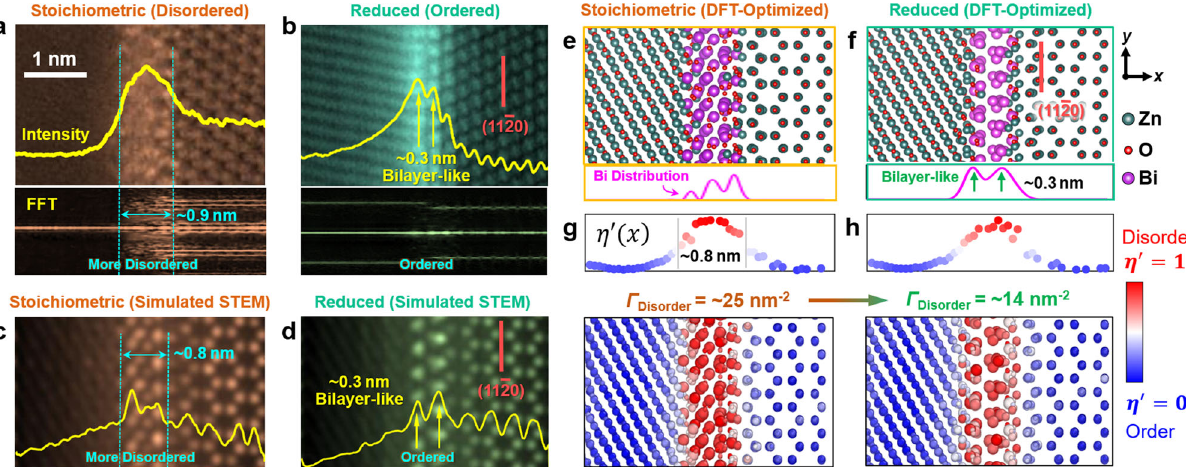
Fig. 5 Comparison of experiments and DFT simulations of stoichiometric (disordered) vs. reduced (ordered) GB structures and AIMD-simulated GB diffusivities. Expanded experimental STEM HAADF images for a a disordered and stoichiometric GB vs. b an ordered (bilayer-like) and reduced GB; here, we plot the averaged HAADF intensity and line-by-line FFT patterns to illustrate the layering and periodic orders. Simulated STEM HAADF images for c stoichiometric GB vs. d reduced GB, respectively, based on DFT-optimized structures of e the stoichiometric vs. f reduced GBs, where the projected Bi density pro fi les are plotted beneath. The calculated disorder parameters for all atoms for DFT-optimized g stoichiometric vs. h reduced GB structures. The projected disorder parameter pro fi les ( η 0ð x Þ ) are shown above. The GB excess of disorder (computed by integrating η 0ð x Þ ) decreases from Γ = ~25 nm − 2 for the stoichiometric GB to Γ = ~14 nm − 2 for the reduced GB, thereby showing that the oxygen reduction induces GB Disorder Disorder